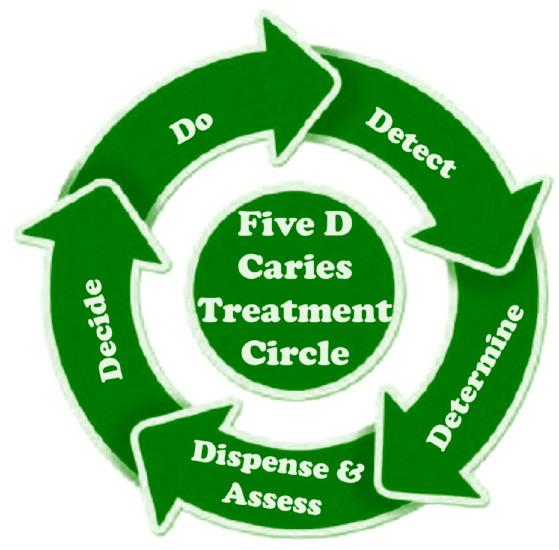
Figure 10. Diagram of Deming’s circle adopted for the fives’ rule on the 5D Caries Management Cycle Rules 5D (CMCRs) for the continuous improvement of the level of the patient’s oral health state.